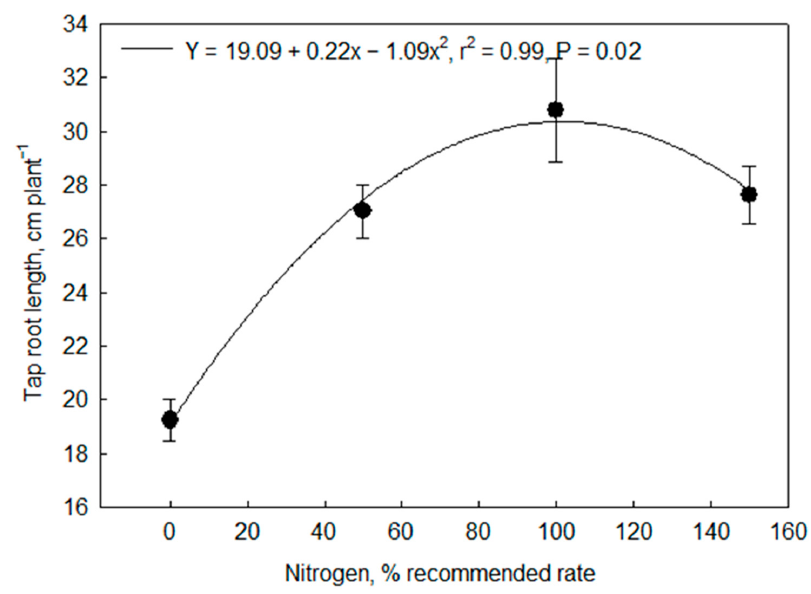
Figure 7. Nitrogen treatment effect on taproot length of cotton at 60 days after planting. Data are means ± Standard error ( n = 64 plantsin total for fourreplications and two runs).